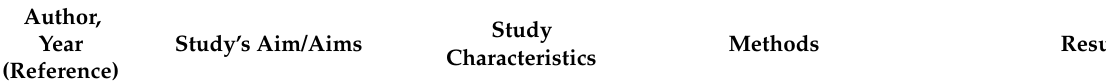
Table 1. Description of the reviewed studies: study design and